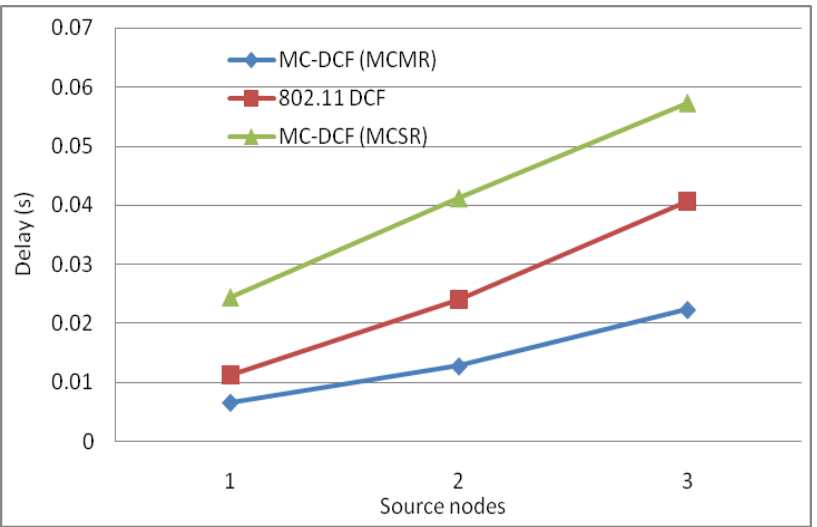
Figure 7. Delay impact with multichannel multi-radios communication at sink